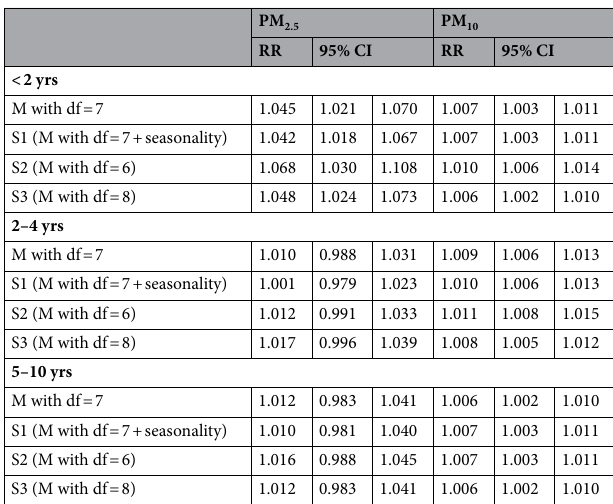
Table 3. Results of sensitivity analysis for different long-term trends and seasonality.